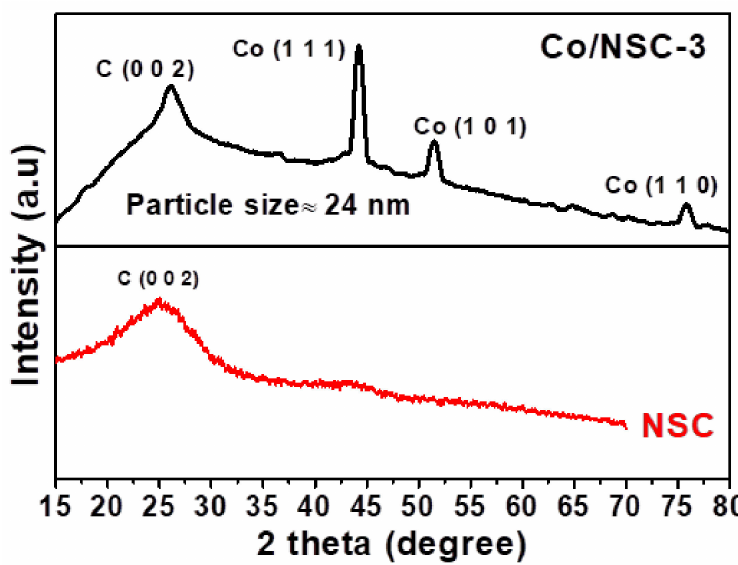
Figure 1. XRD patterns of NSC and Co/NSC-3 catalysts.